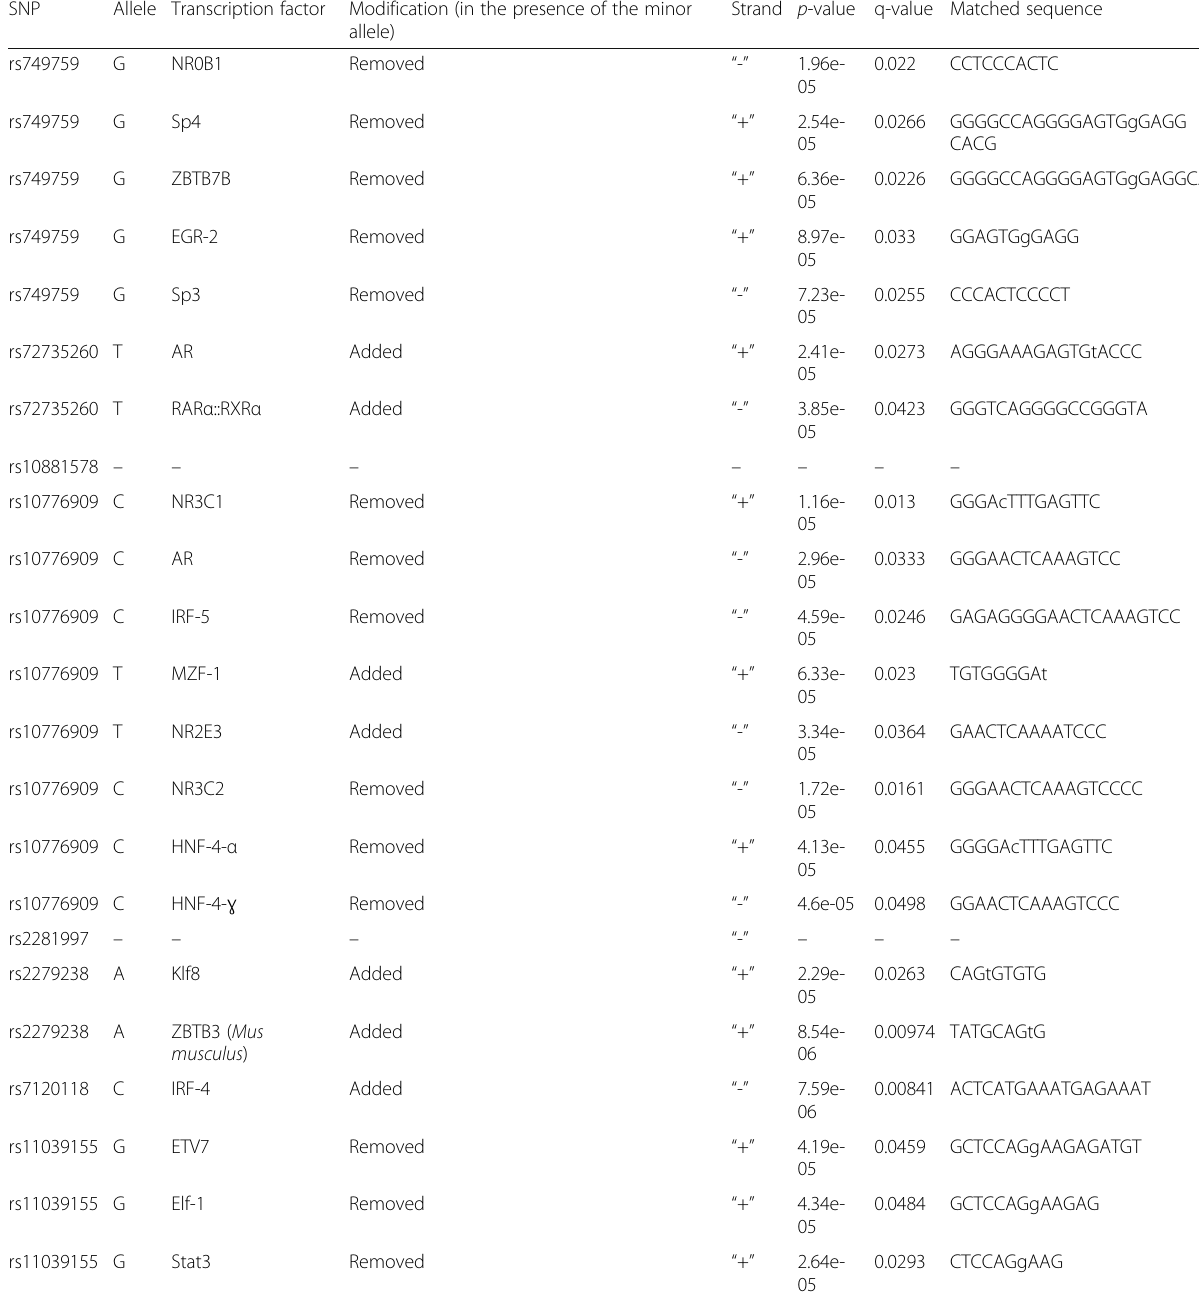
Table 4 Results of the transcription factor binding site prediction according to the software FIMO for the tested SNPs SNP Allele Transcription factor Modification (in the presence of the minor Strand p -value q-value Matched allele)